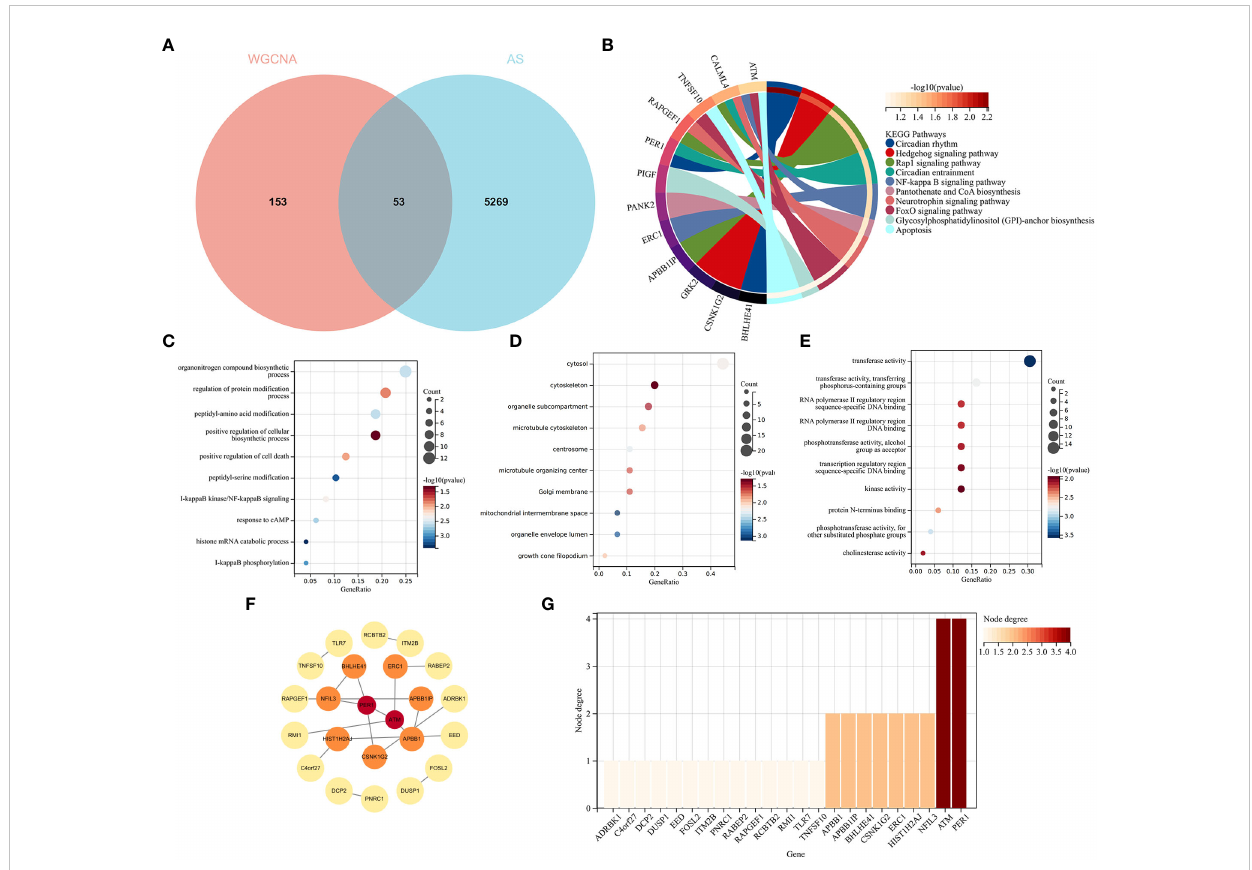
FIGURE 5 Functional enrichment analysis of common genes from RA with AS and the recognition of node genes with the PPI network. (A) Venn diagram shows 53 genes are recognized from the intersection of genes in RA with Limma and SLE with WGCNA. (B) KEGG analysis of 53 common genes. (C – E) GO analysis (biological process, cellular component, and molecular function) of 53 common genes. (F) The PPI network demonstrates that 23 genes interact with each other. (G) The column shows the gene nodes of 23 genes in the PPI